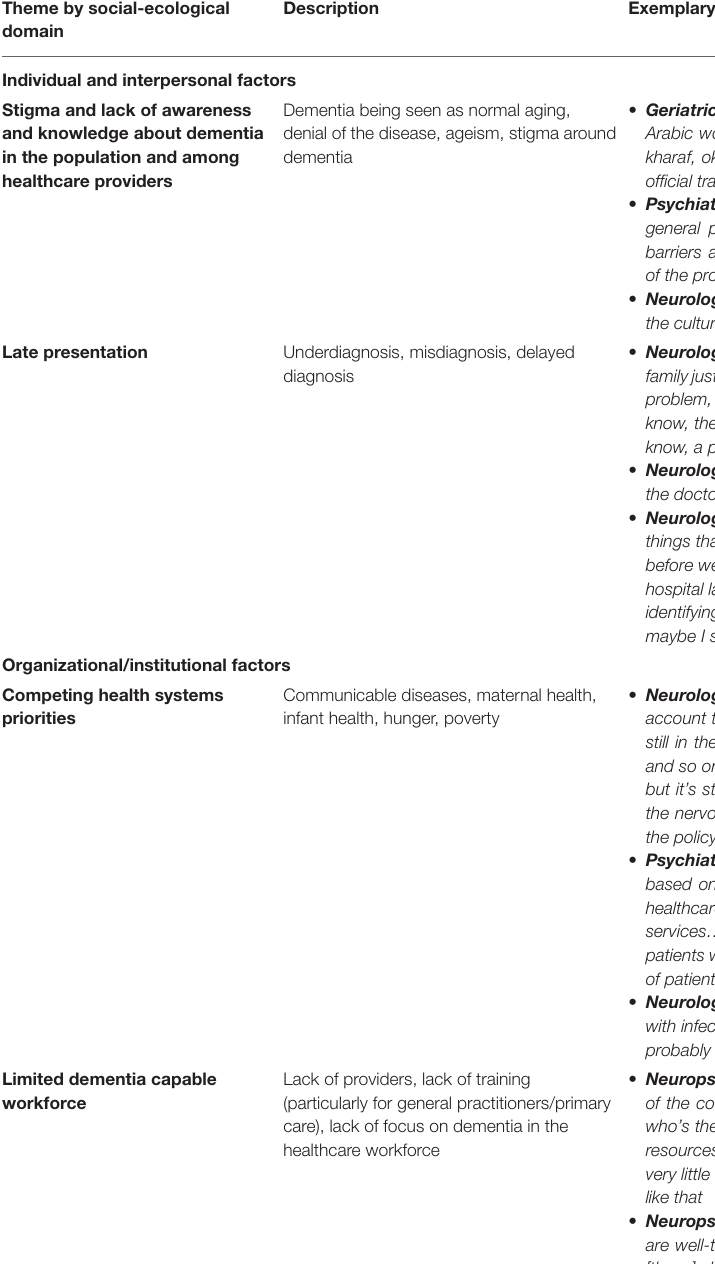
TABLE 3 | Barriers to dementia assessment and